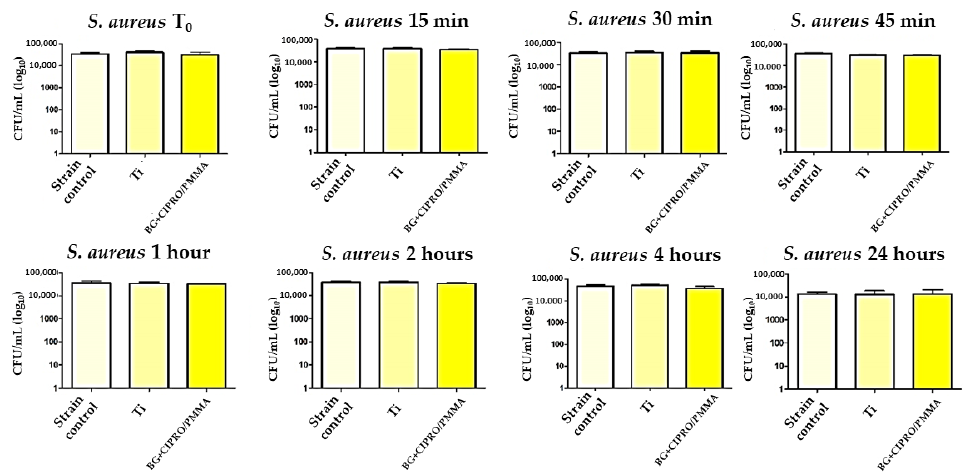
Figure 13. Evaluation of S. aureus viability in the presence of bare Ti and BG+CIPRO/PMMA samples.